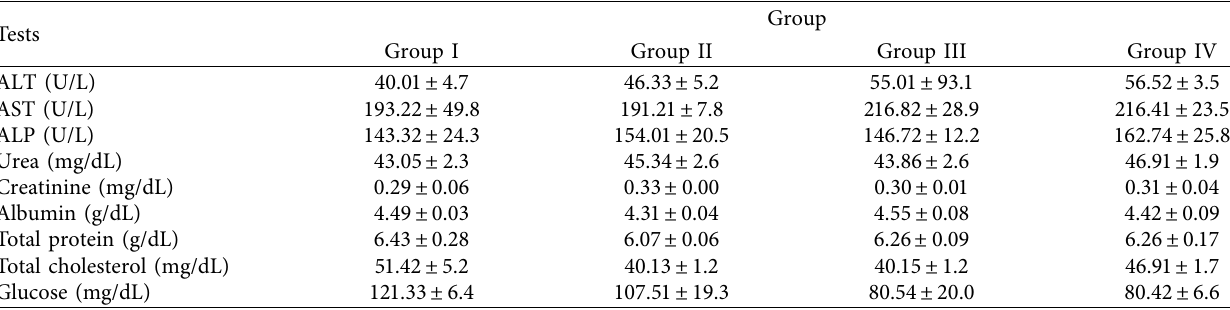
Table 4: Biochemical profle of male rats treated with leaf extract of R. prinoides